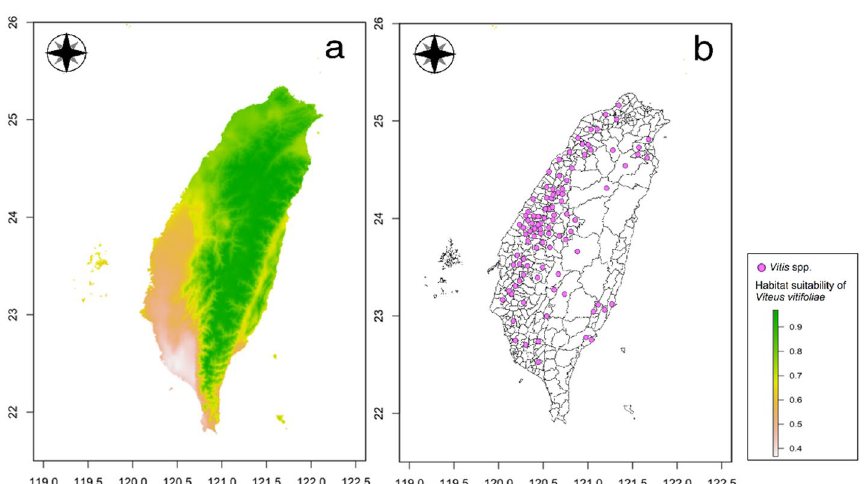
Figure 9. Comparison of potential distribution area of Viteus vitifoliae and cultivation areas of Vitis spp. in Taiwan: ( a ) potential distribution ( b ) cultivation areas. Maps were created using R version 4.04 (https:// www.r- proje ct. org/) and QGIS version 3.12.1 (www. qgis.